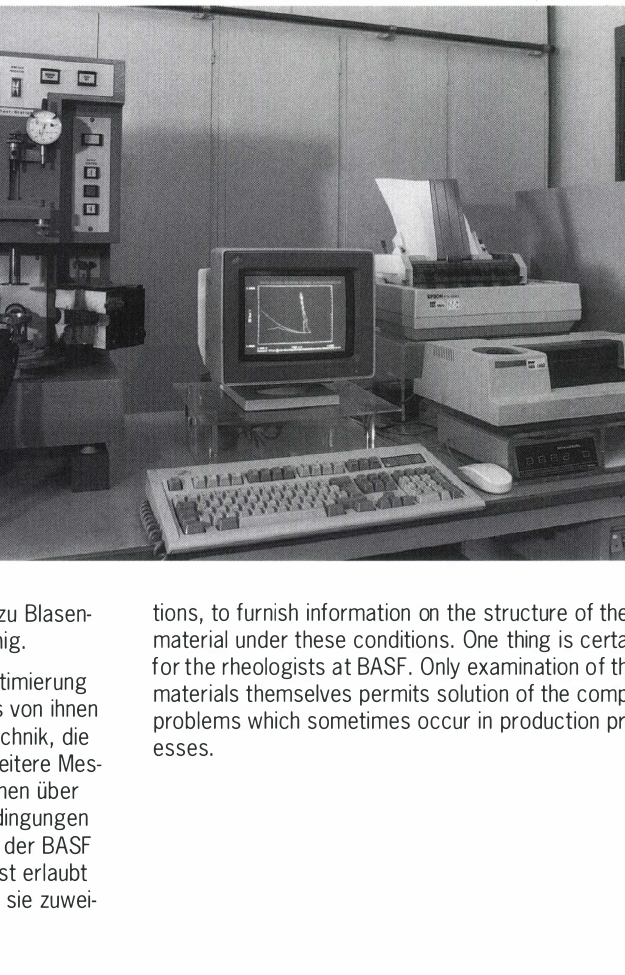
Abb. 3: Viskositiitsfunktion einer